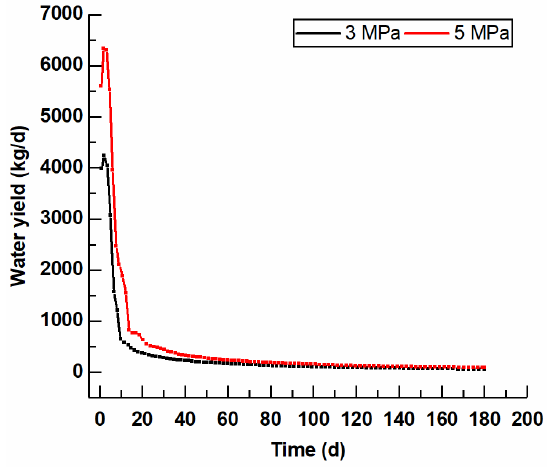
Figure 10. Water yield of production well in the gas flooding pressure of 5 and 3 MPa.